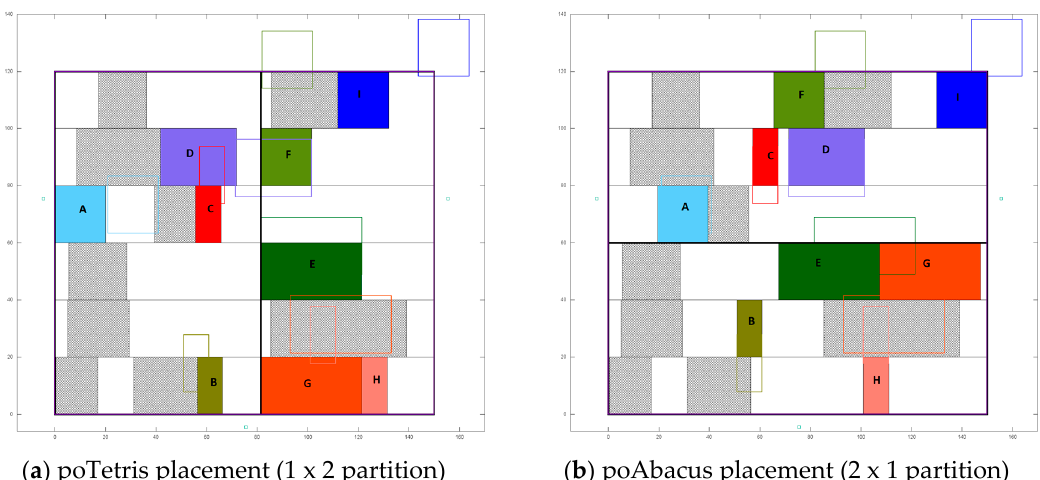
Figure 3. Obstacle-aware placement with tiles